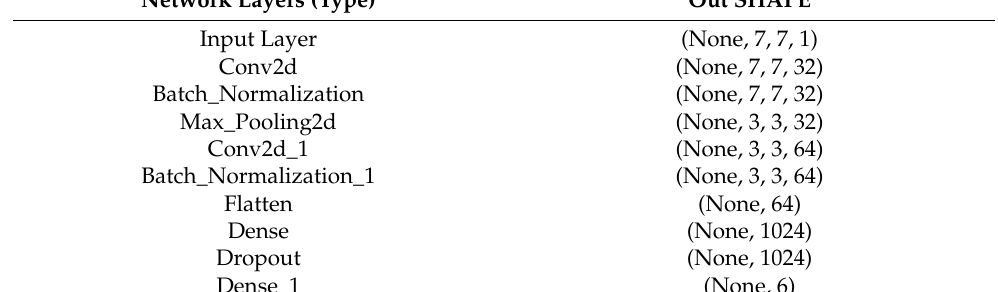
Table 2. CNN model structure.